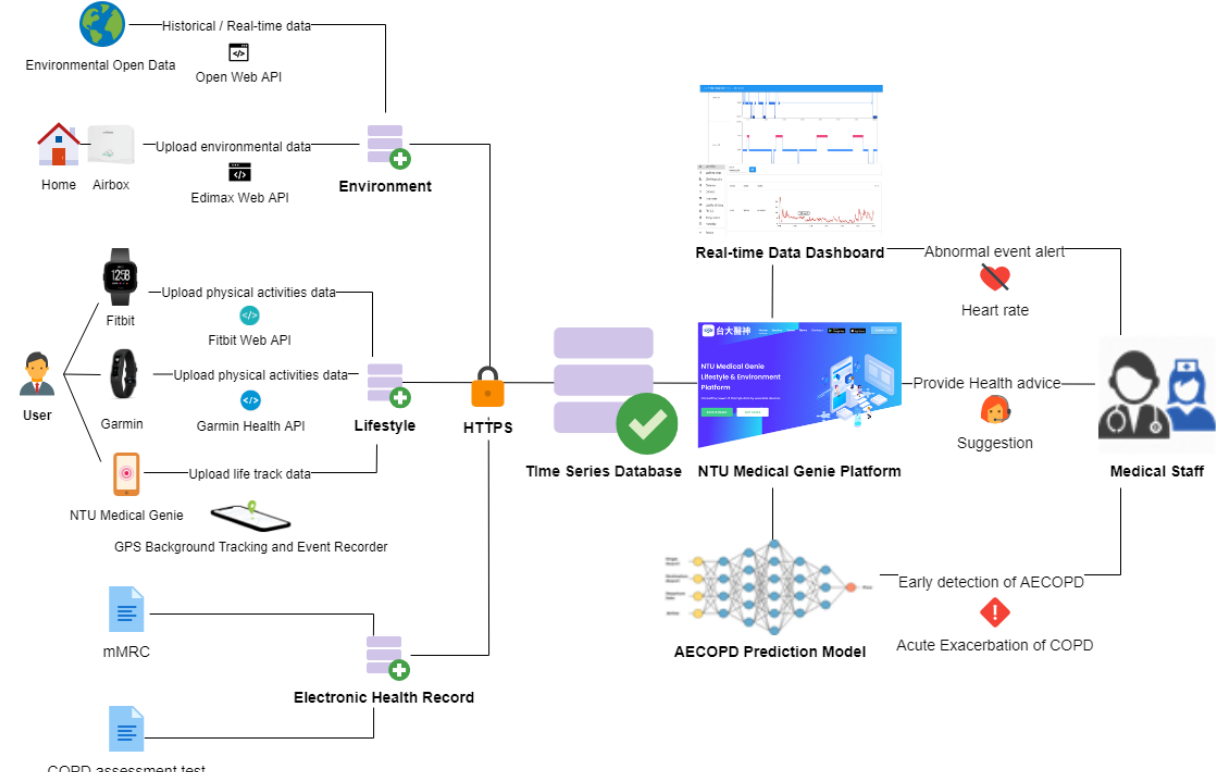
Figure 1. System architecture of the acute exacerbation of chronic obstructive pulmonary disease (AECOPD) prediction system. API: application programming interface; COPD: chronic obstructive pulmonary disease; mMRC: modified Medical Research Council dyspnea